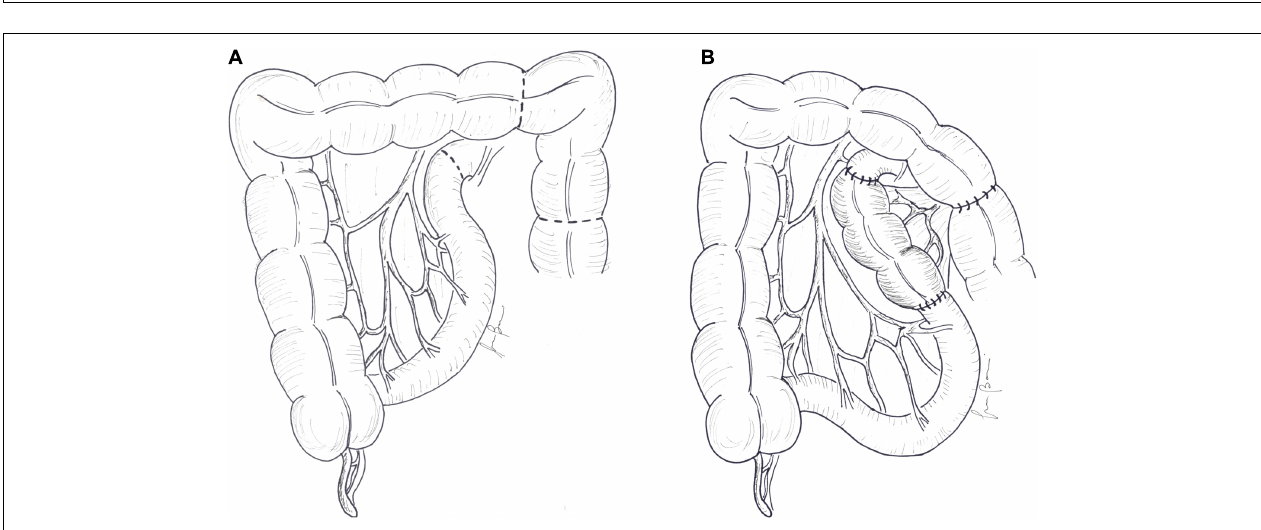
FIGURE 2 | Colonic interposition: (A) 10–15 cm of the colon is divided and (B) interposed proximal to the remaining small bowel.